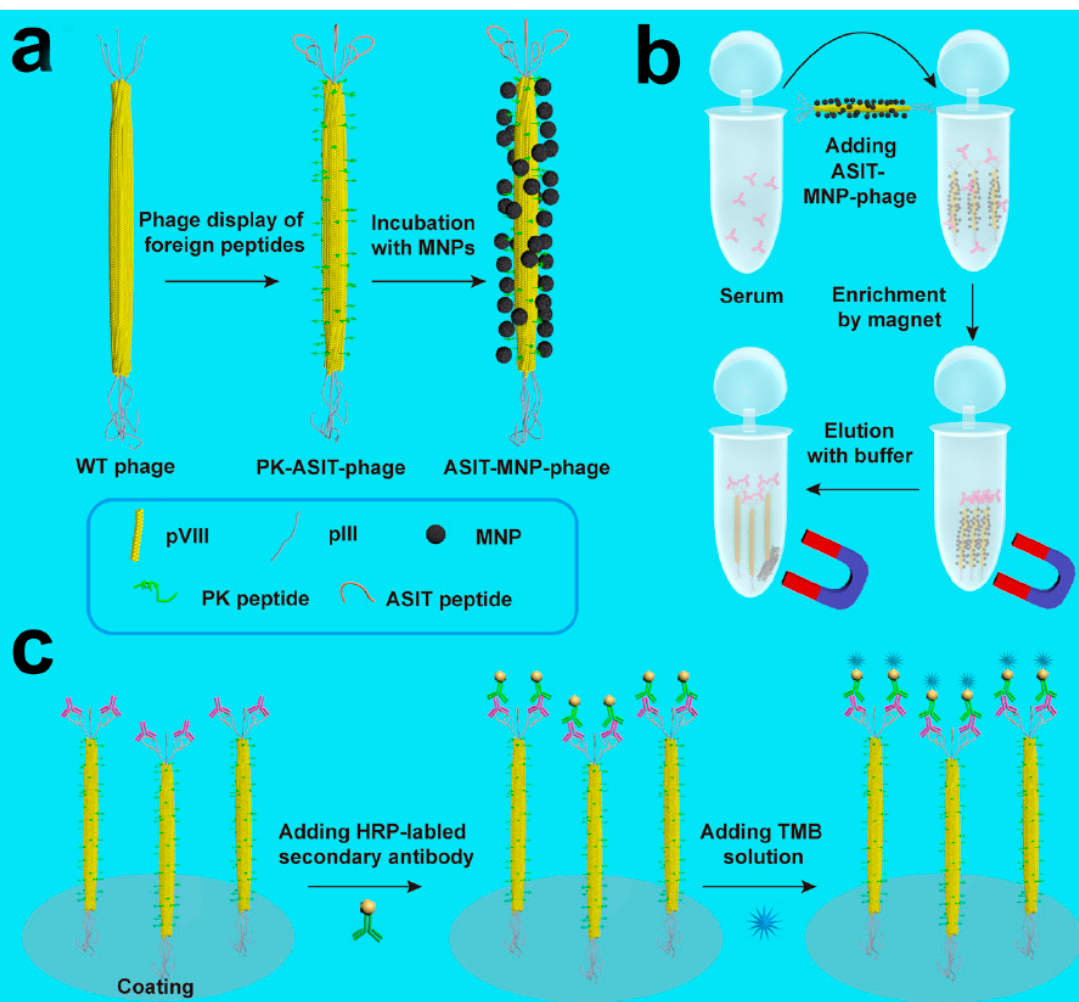
Figure 6. The “Nanofiber” capture antibody detection strategy. ( a ) The peptides “PK”(MNP-binding) and “ASIT” (anti-Sap2-IgG-binding) are displayed on the pVIII protein (the major envelope protein on the side wall) and the pIII protein (top secondary envelope protein) of the wild-type phage, respectively. Then, MNPs bind to the MNP-binding peptide, forming the ASIT–MNP–phage complex. ( b ) ASIT-MNP-phages were added to human serum to capture biomarkers through its pIII tip (anti-Sap2-IgG), and were enriched with a magnet, followed by elution. ( c ) The eluted ASIT-phage/biomarker complex was then coated on the ELISA plate, and Horseradish peroxidase (HRP)-labeled bis-antibody and TMB staining solution were added to the synthesized complex to form a chromogenic reagent for detecting biomarkers. PK, MNP-binding peptide (PTYSLVPRLATQPFK); ASIT, anti-Sap2-IgG targeted peptide (VKYTS) [43].